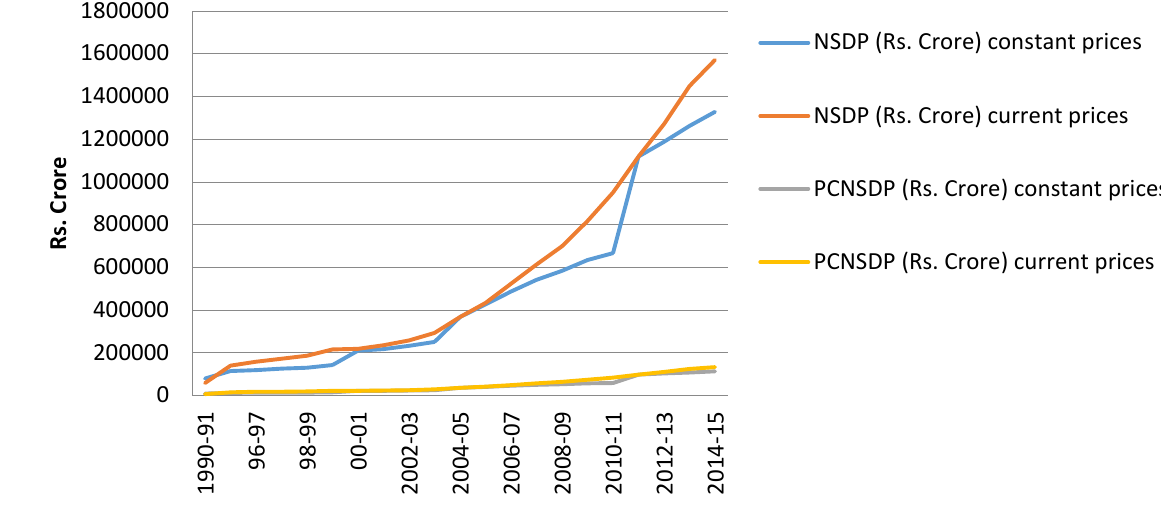
Figure 1. NSDP and Per capita NSDP of the state (Rs. Crore)